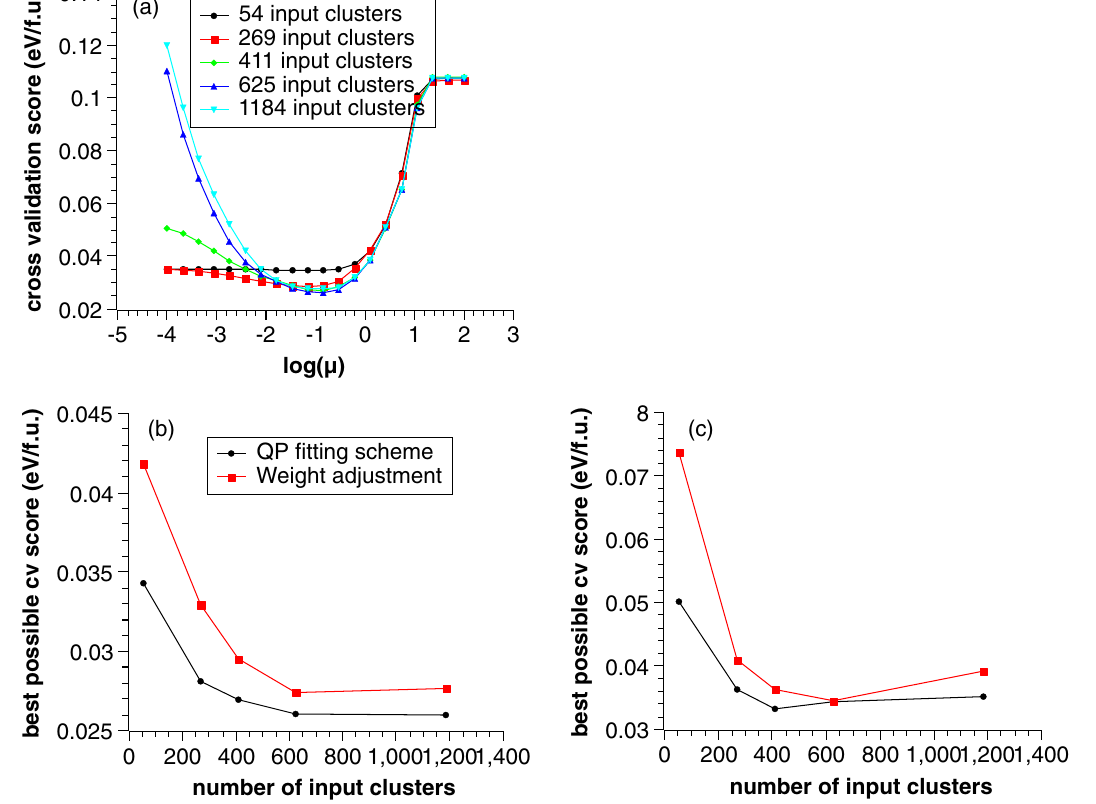
Fig. 3 a Cross-validation (cv) score cv μ plotted as function of the sparseness parameter μ for the example of the Li x Fe (1 − x ) O system for various numbers of input clusters. The optimal μ minimizes the cv score. b , c Optimal cv score for different numbers of input clusters as determined using the QP methodology and the conventional weight adjustment scheme for ( b ) Li x Fe (1 − x ) O and ( c ) Li x Ti (1 − x )